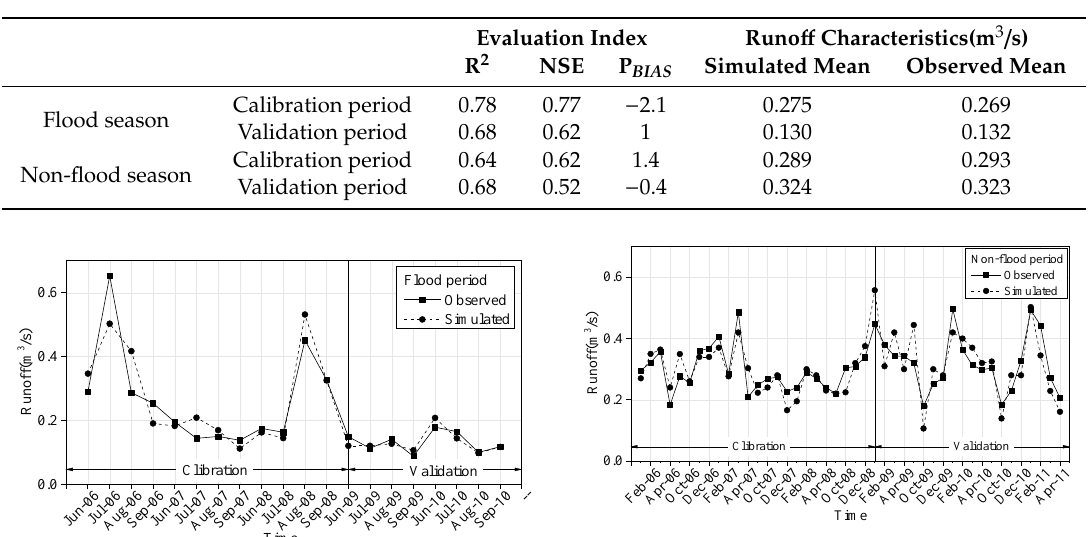
Table 2. Accuracy evaluation of simulated results by the Soil and Water Assessment Tool (SWAT) model.